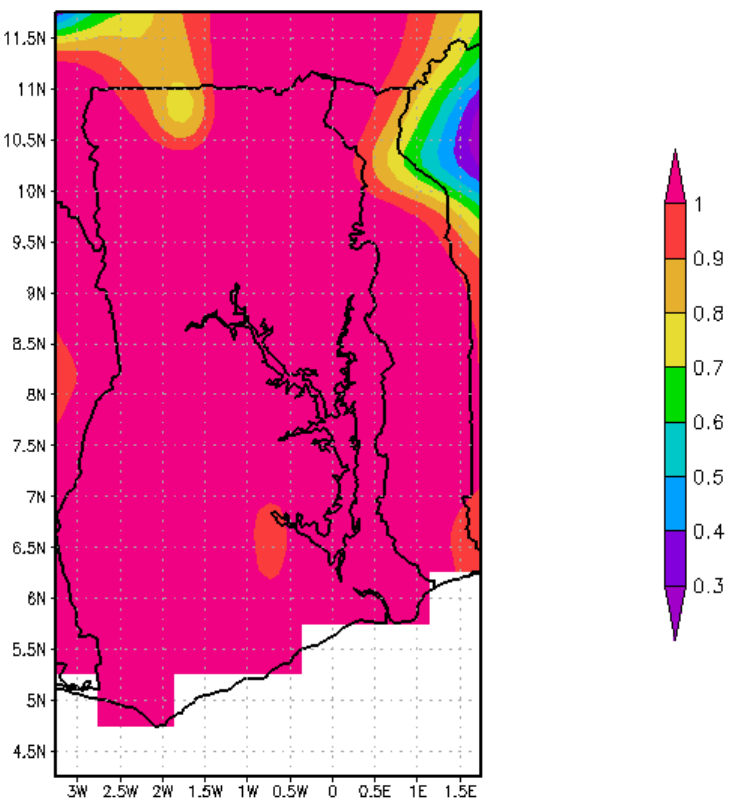
Figure 4. Pearson’s correlation coefficient (r) between GPCC and GMet data from